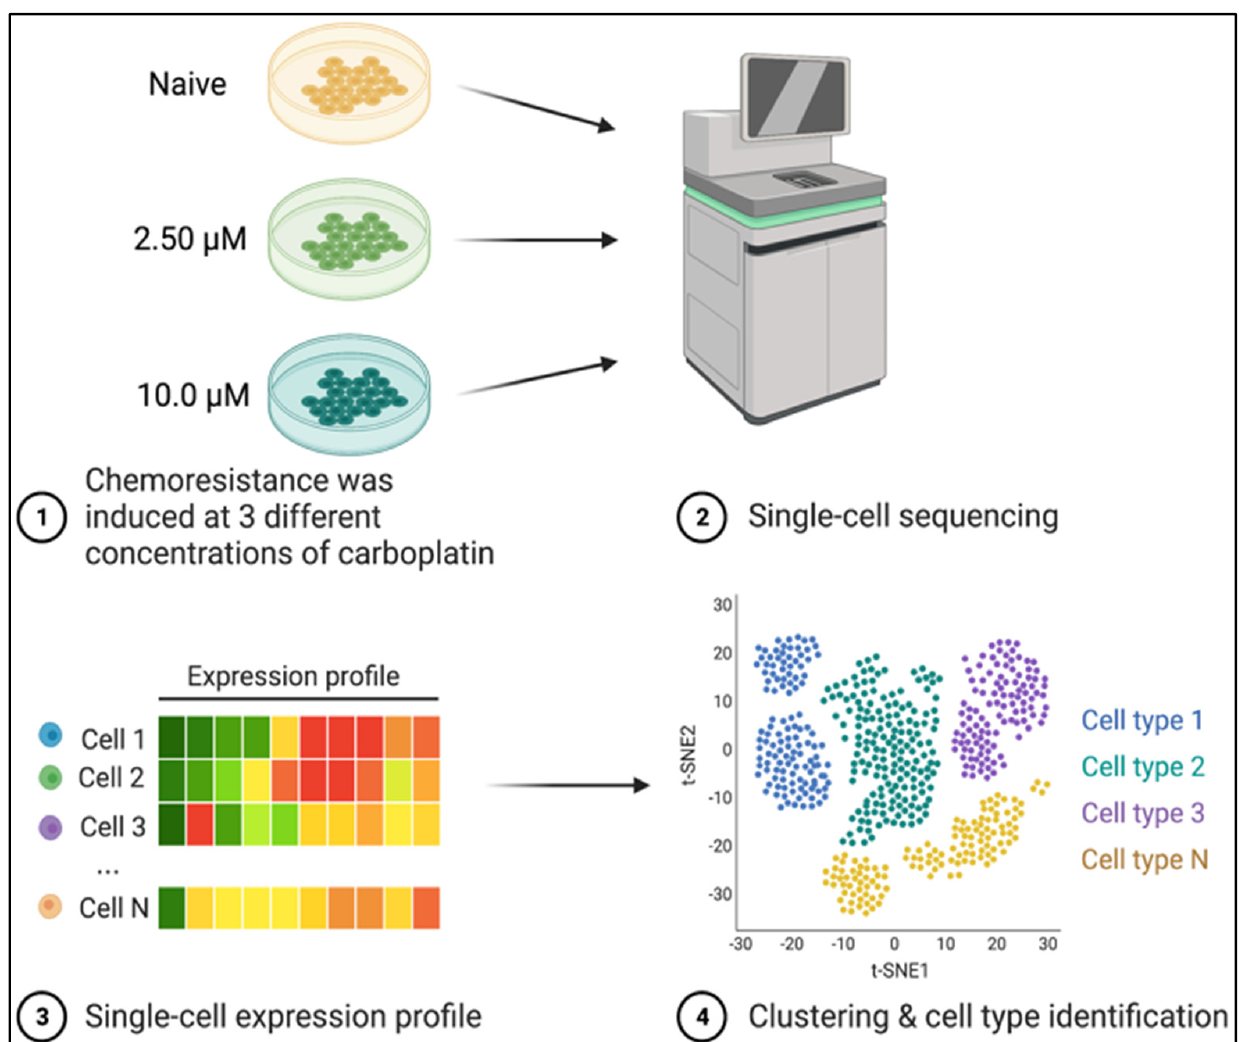
Figure 1. Visual overview of experimental design. HMPOS cell lines were previously challenged with increased concentrations of carboplatin to generate the HMPOS-2.5 μ M and HMPOS-10 μ M drug-resistant cell lines [23]. Single-cell RNA sequencing was performed on these two chemoresistant cell lines and the HMPOS cells. Created with BioRender.com, (accessed on 22 October, 2022) [30].